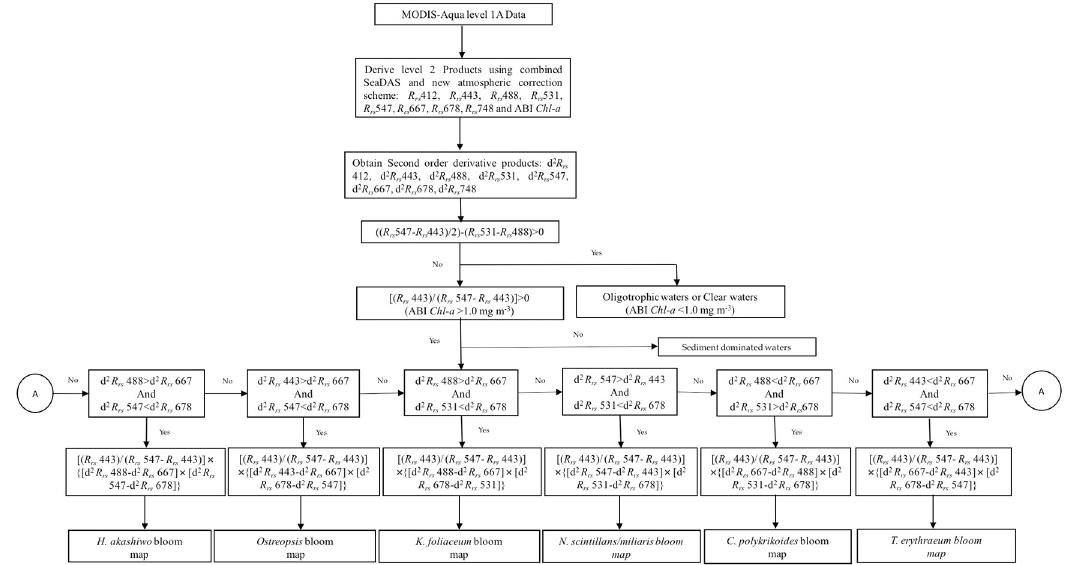
Fig 2. Summary of the steps involved in the development of our model. Flow chart showing the major steps involved in the detection and classification of different Harmful Algal Blooms (HABs) in the Red Sea.